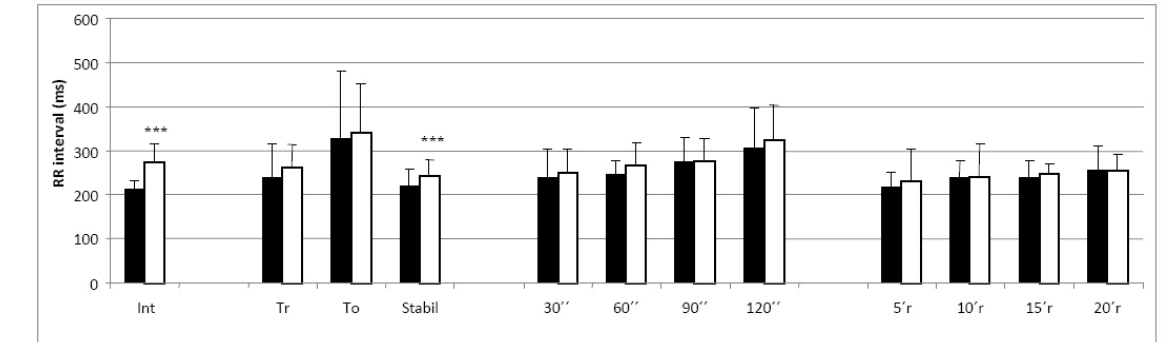
Figure 2. Mean ± SD values of the RR-interval duration in intact animals (Int), after tracheotomy (Tr), thoracotomy (To), 5 minutes after stabilization (Stabil), during each 30 seconds of a 2-minute apnoeic episode, and after 5, 10, 15, and 20 minutes of artificial reoxygenation. Empty and black columns refer to light and dark parts of the day, respectively. The level of significance of differences between the light and dark part of the rat daily regimen is indicated by the symbol (* p < 0.05, ** p < 0.01, *** p <